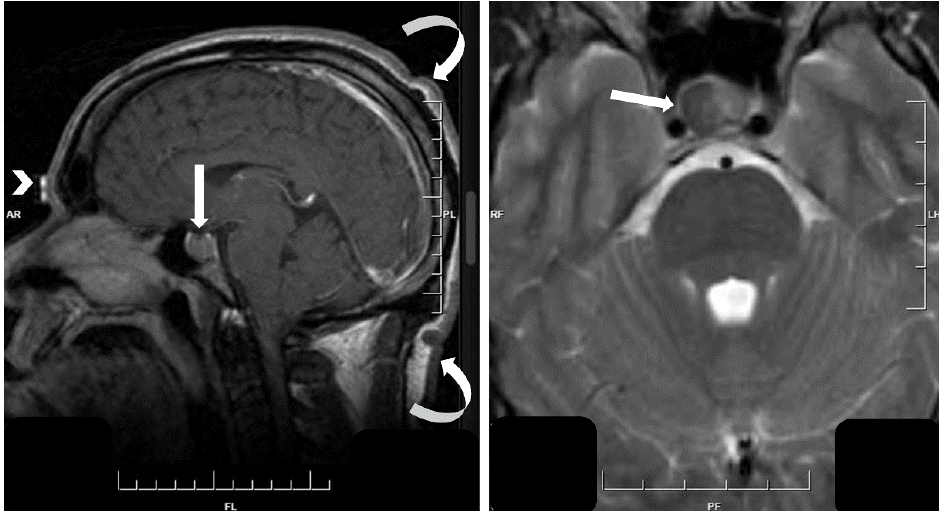
Figure 2. Magnetic resonance imaging of densely granulated somatotroph tumor. The sella turcica contains an intrasellar tumor ( left , straight arrow); on T2-weighted imaging it is hypointense ( right , straight arrow). Note the evidence of acromegaly in the thickened wavy skin ( left , curved arrows) and frontal bossing ( left , chevron).